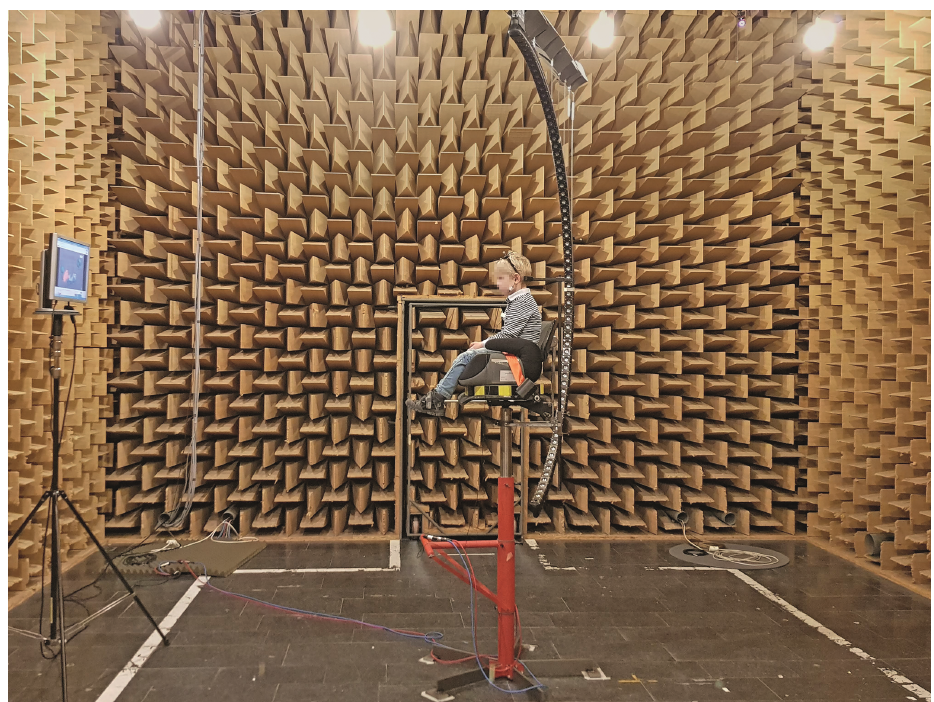
Figure 1. Child during the fast HRTF measurement sitting in measurement system consisting of a 64-loudspeaker arc, a height adjustable chair and monitor in front of the